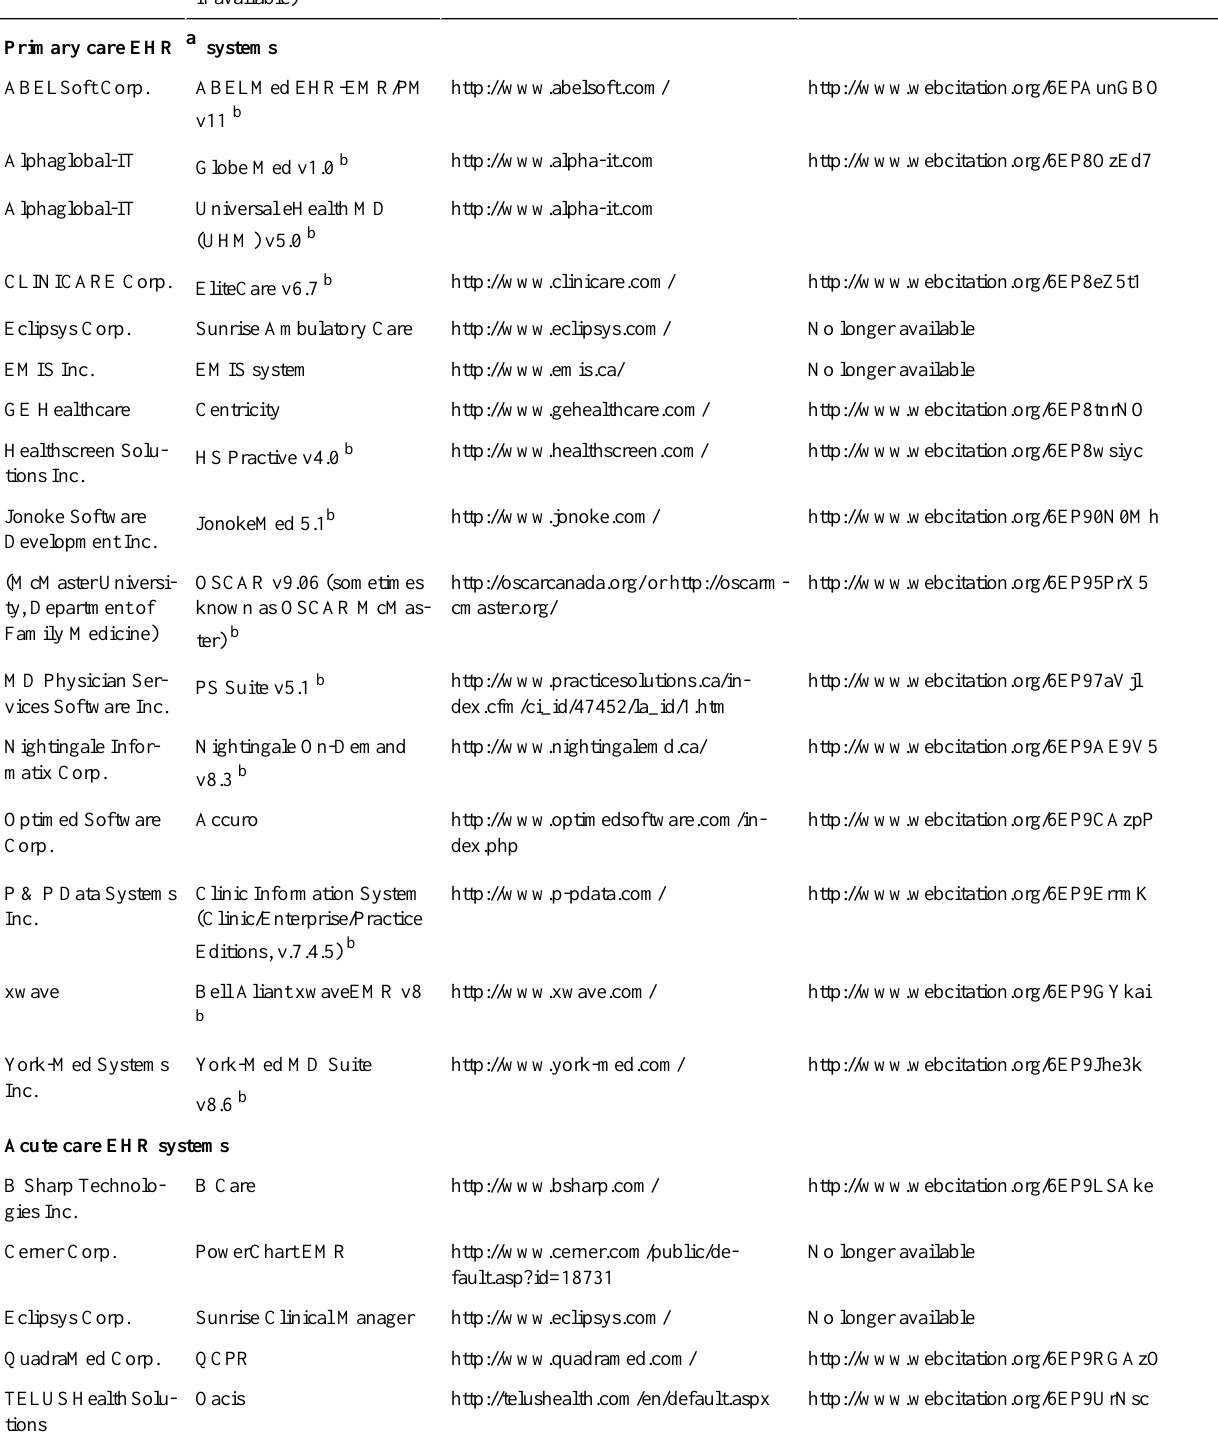
Table 1. List of all systems included for